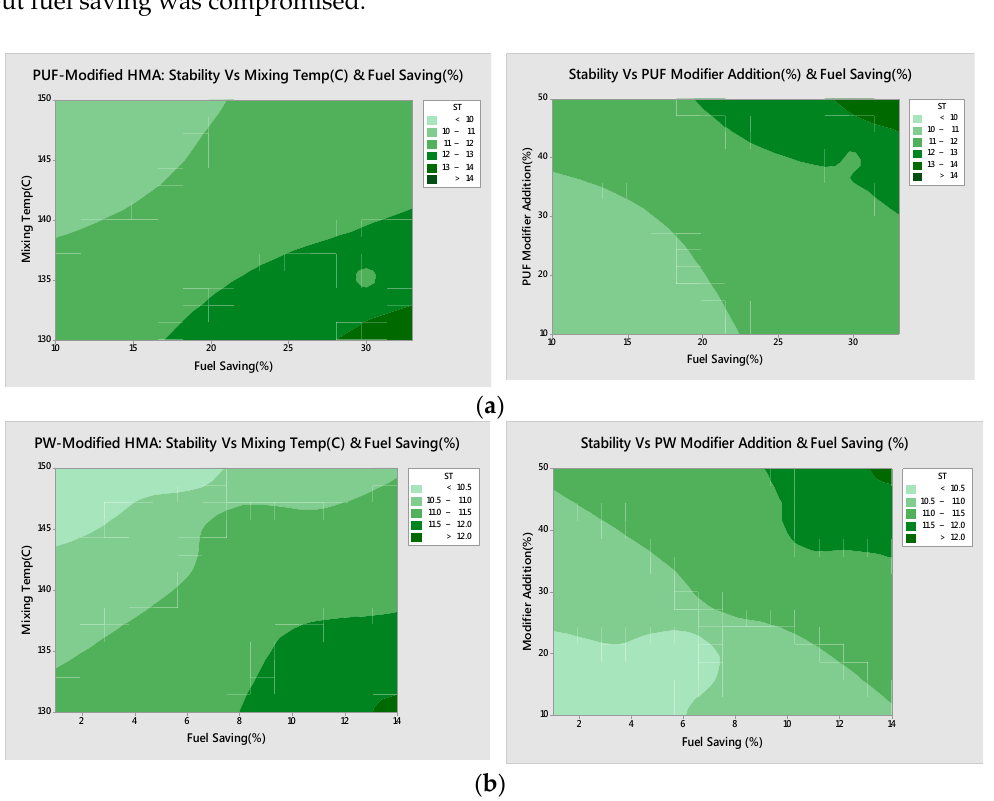
Figure 4. Fuel consumption savings during asphalt mixing: ( a ) PUF and ( b ) PW modified bituminous mix.